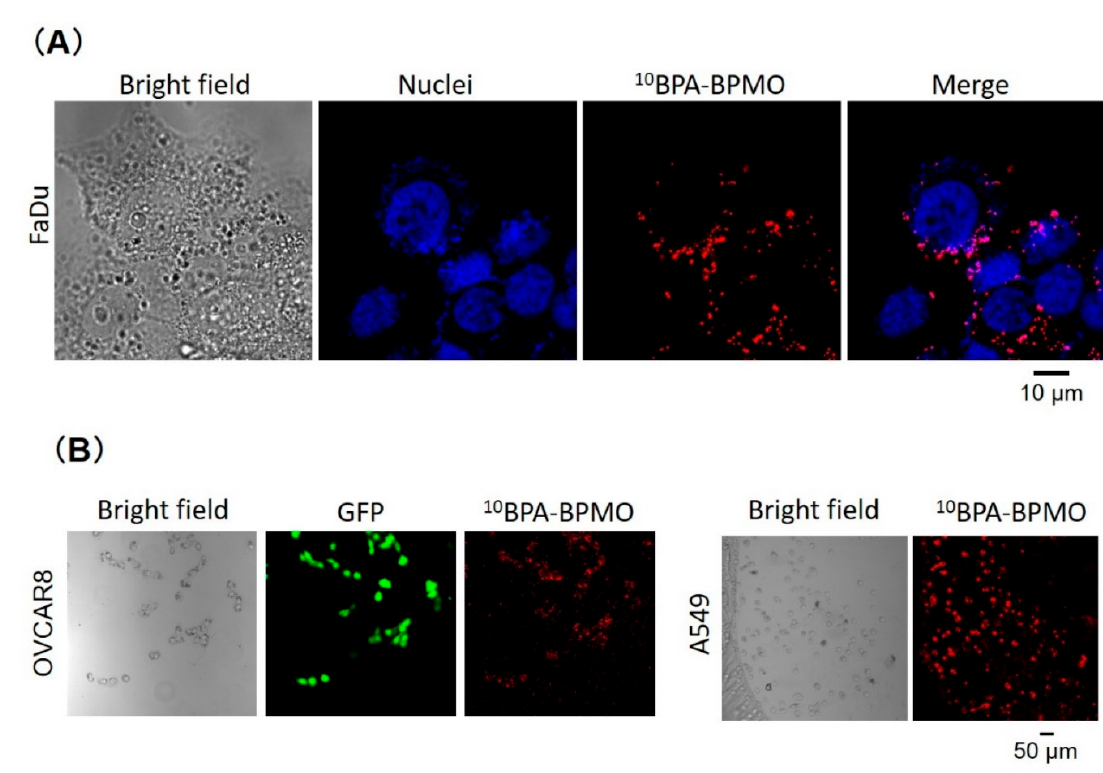
Figure 4. Cellular uptake of BPA-BPMO. ( A ) Confocal microscopy images of FaDu cells after incubation with BPA-BPMO. Images of bright field, nuclear staining with Hoechst dye, and red fluorescence of BPA-BPMO nanoparticles are shown. The rightmost picture shows overlay images of nuclei and nanoparticles; ( B ) Uptake of BPA-BPMO into OVCAR8 and A549 cells.